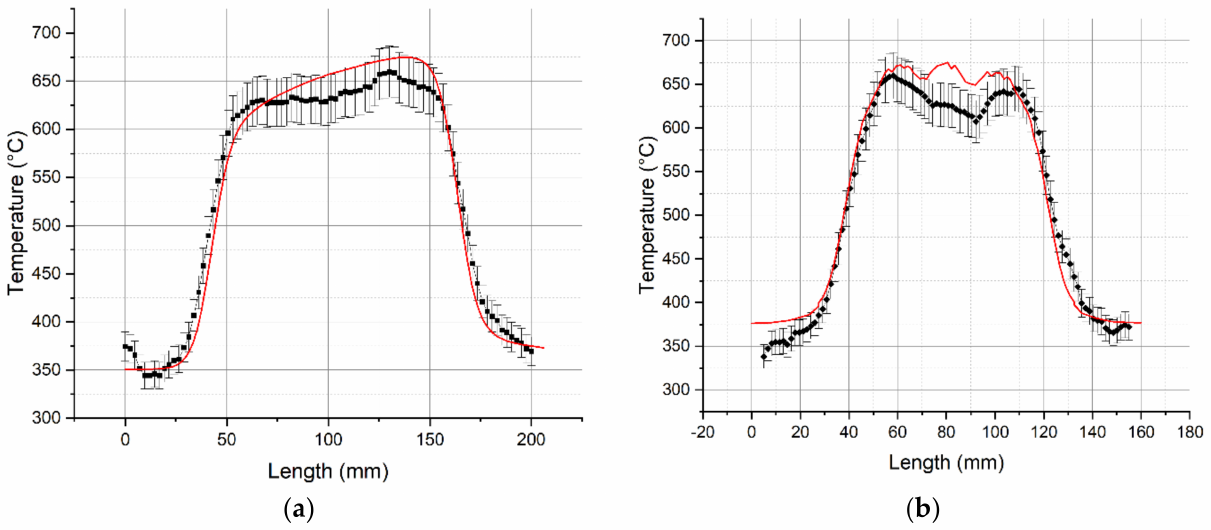
Figure 20. Temperatures profiles across the ODS mock-up in run of 7 October 2019: ( a ) longitudinal; ( b ) transversal. The numerically simulated profiles are drawn with red continuous